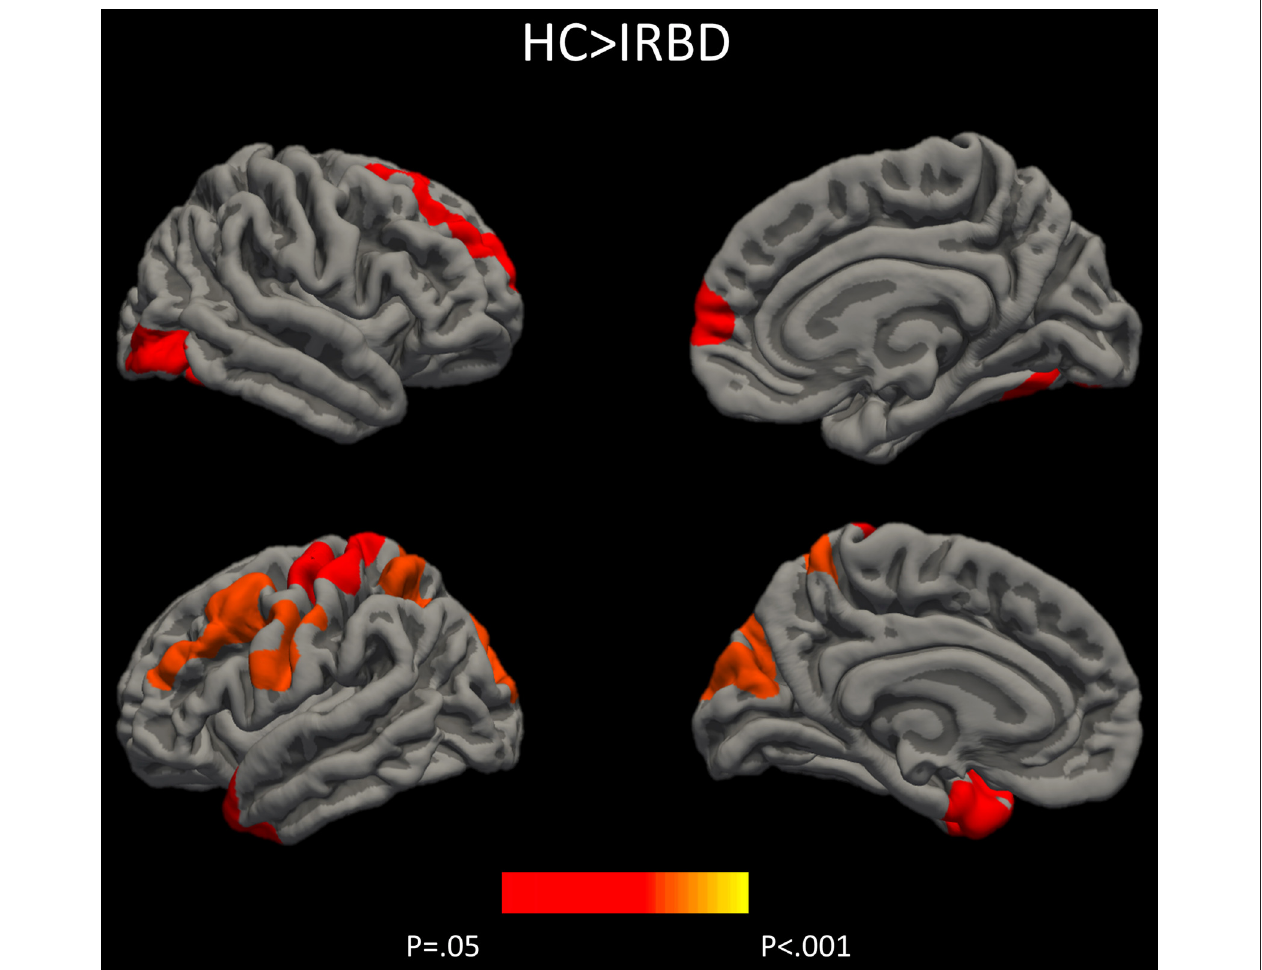
FIGURE 1 | Differences between HC and IRBD patients in cortical thickness. Image show vertex-wise cortical thickness differences between HC and IRBD patients when age was introduced as covariate. Significant clusters are highlighted in warm colors. Results after FWE correction with Monte Carlo simulation and threshold at p ≤ 0.05. Graphics program: Freeview from FreeSurfer (https://surfer.nmr.mgh.harvard.edu/fswiki/FreeviewGuide), and edited with Microsoft PowerPoint ®